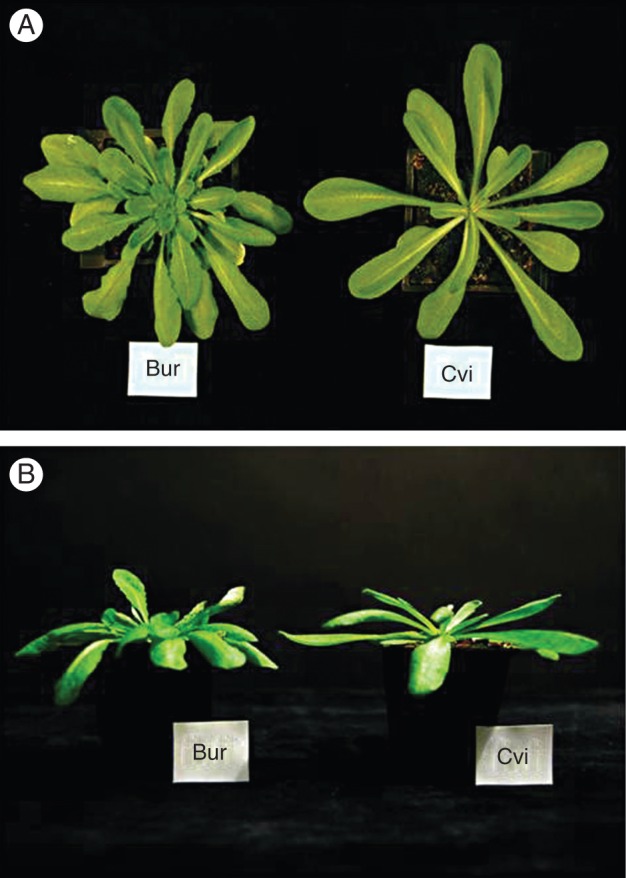
Plant phenotypes at 28 d after sowing in the common environment: 23/17 °C, 12/12 h, light/dark. (A) Overhead view of the Bur and Cvi rosettes; (B) side view of the Bur and Cvi rosettes.